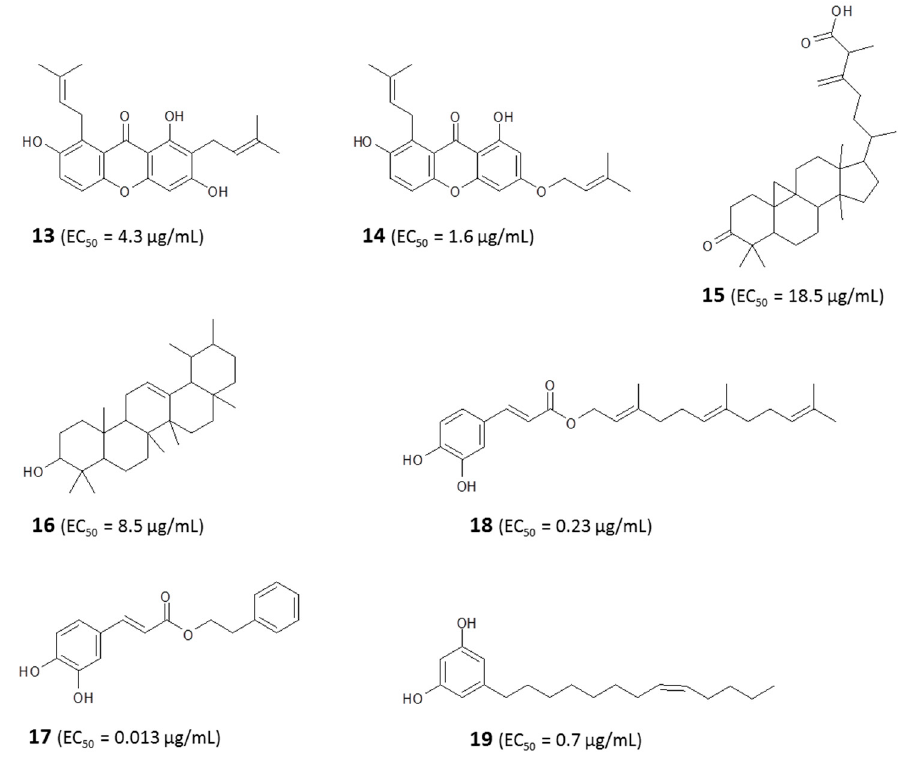
Figure 3. Structures of some compounds with activity against Trypanosoma brucei , isolated from propolis. The 50% effective concentrations (EC 50 ) against the parasites in culture are indicated where available. Reference for EC 50 values: Omar et al., 2016, 2017; Siheri et al., 2019 [14,15,59].